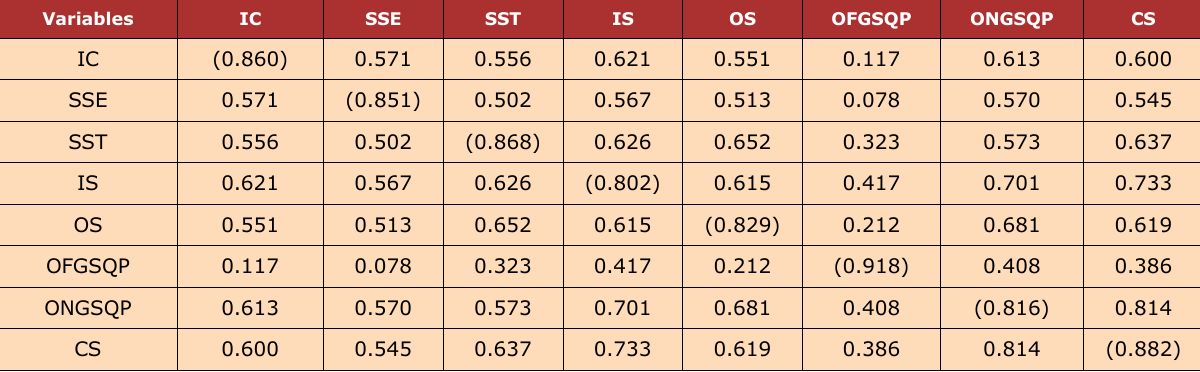
Table 4. Construct correlations with the square root of AVE along the